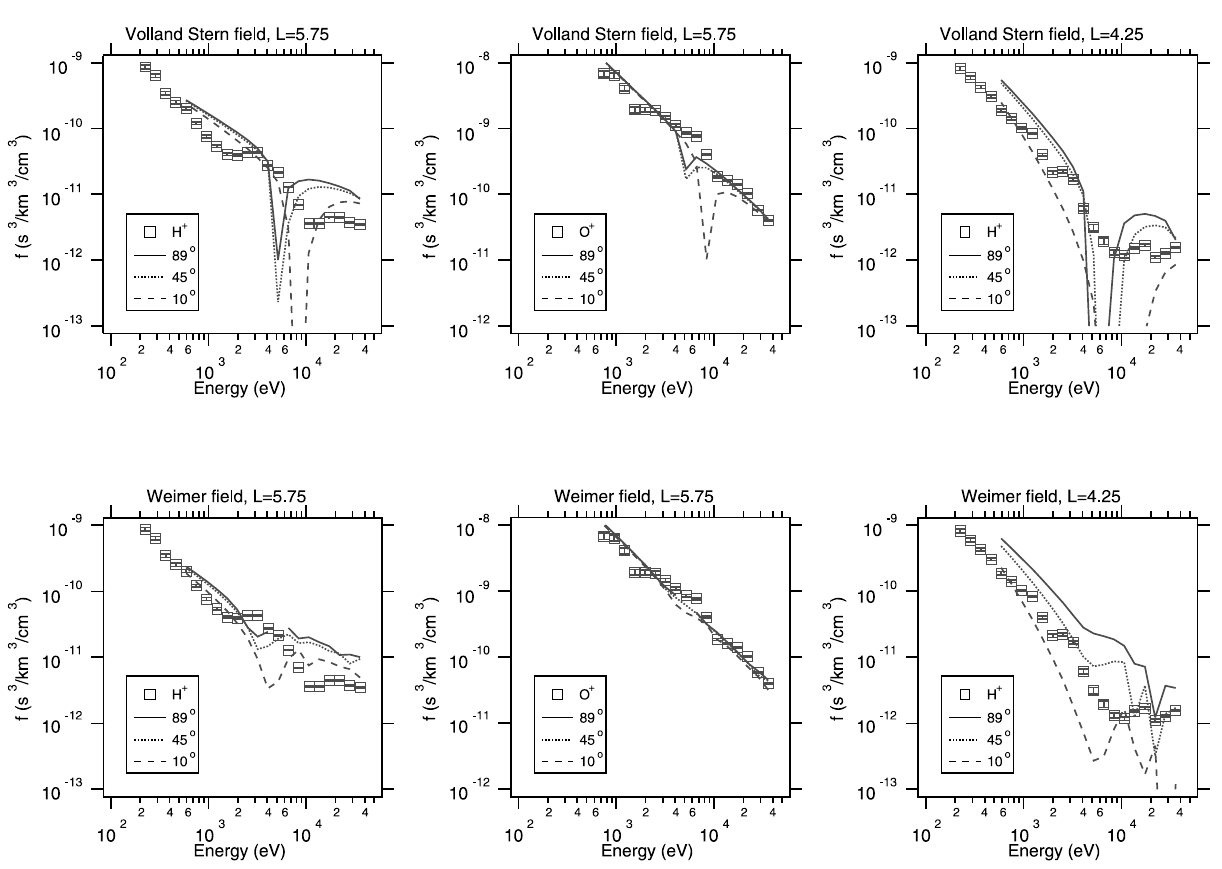
Fig. 9. Comparisons of observed spectra and modeled spectra using the Volland-Stern electric field ( top panels ) and the Weimer electric field ( bottom panels ) assuming charge exchange is the only loss mechanism. The symbols show the data, and the lines give the model results